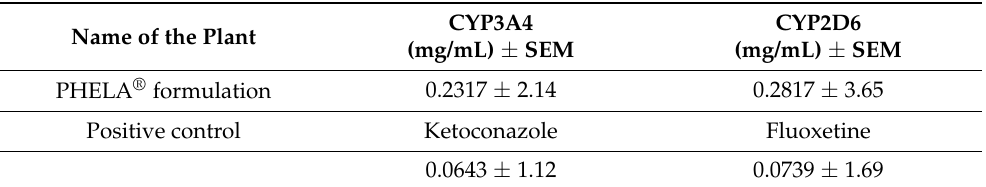
Table 2. IC 50 values ( µ g/mL) of PHELA ® formulation and individual plant extracts against CYP3A4 and CYP2D6 isozyme by the PHELA ® formulation and individual plant extracts.